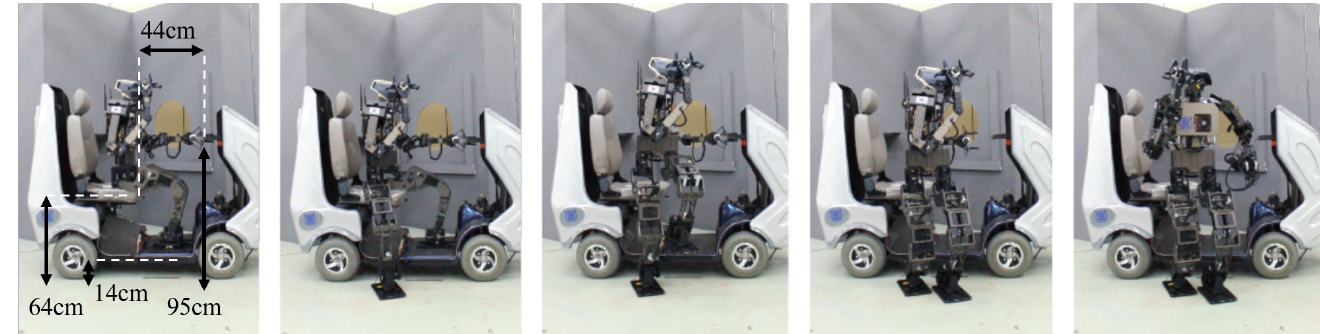
Figure 12. Snapshots of egress test with personal mobility. Videos can be seen at https://youtu.be/6NWdPNTjnjs (accessed on 1 July 2021).